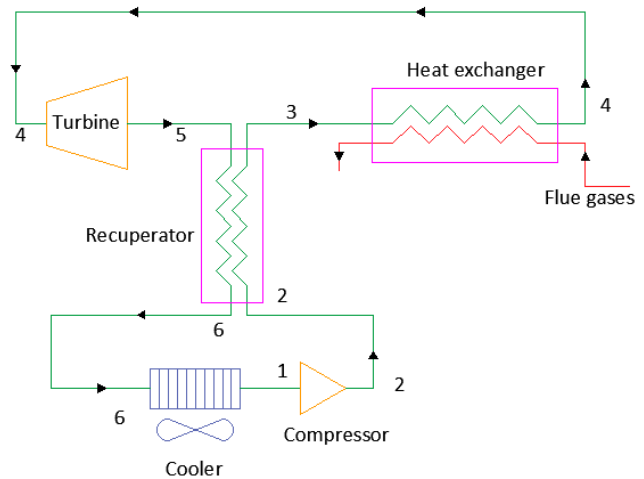
Figure 1. Schematic of a simple supercritical Brayton cycle with CO 2 (S-CO 2 ) cycle.